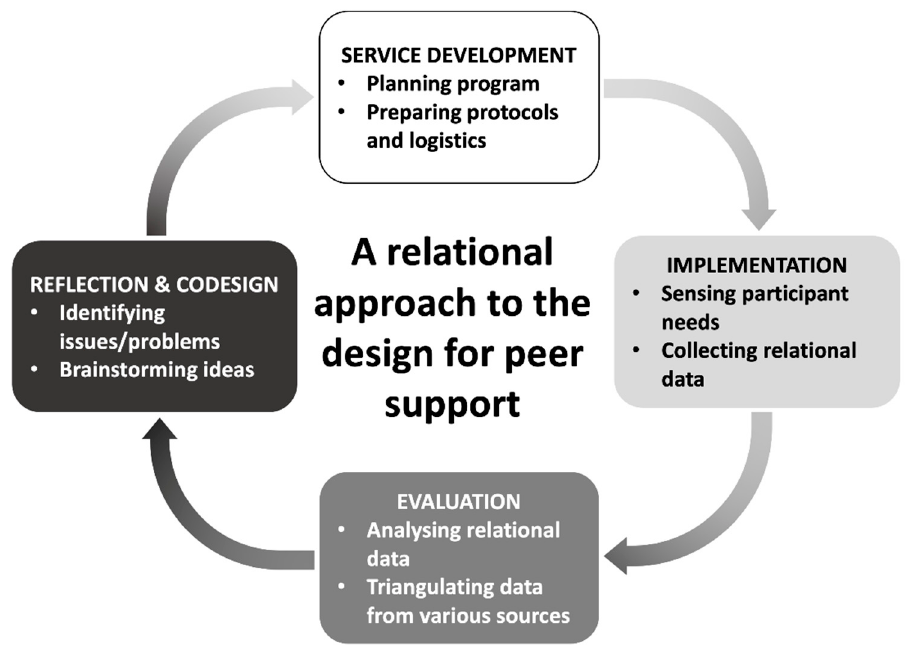
Figure 7. Process of designing peer-support services from a relational perspective.